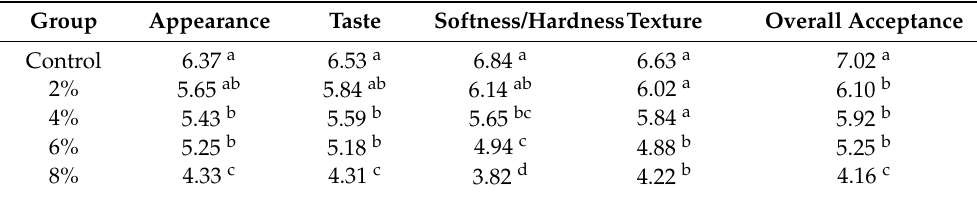
Table 3. Consumer preferences toward breads made by partially substituting high-gluten flour with soy protein isolate. Group Appearance Taste Softness/HardnessTexture Overall Acceptance Control 6.37 a 6.53 a 6.84 a 6.63 a 7.02 a